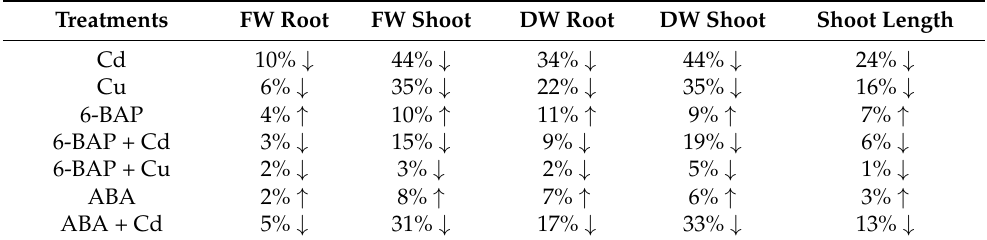
Table 3. The increasing and decreasing percentage of fresh/dry weight of root and shoot as well as shoot length in the bamboo species exposed to 100 µ M cadmium and 100 µ M copper in single and combined forms with 10 µ M 6-BAP and 10 µ M ABA, compared to the control treatment. ↑ indicates increases and ↓ indicates